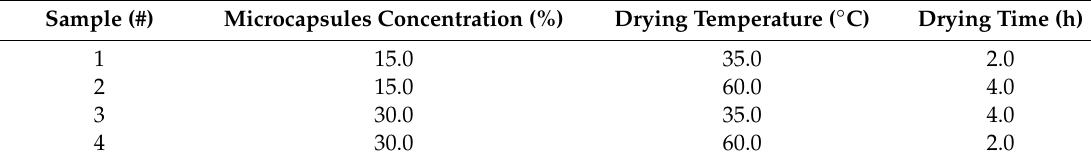
Figure 2. A Schematic diagram of sample 4#. Table 1. Orthogonal experiment design.